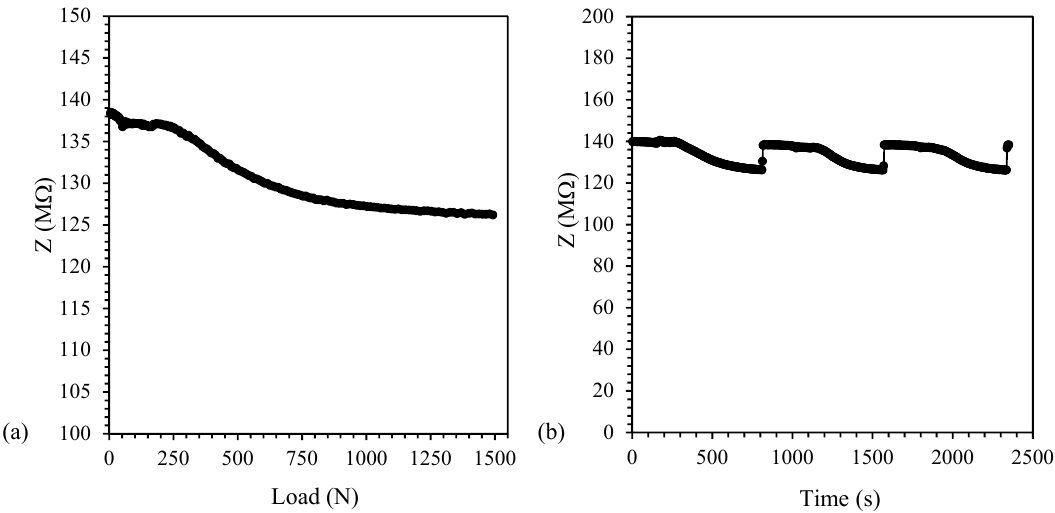
Figure 10. Impedance value for PP / CNT-3 nanocomposites. ( a ) Impedance (Z) variation vs. load and ( b ) load / unload cycles.